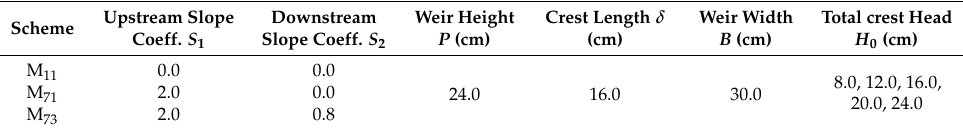
Table 3. Range of variables for laboratory measurements.